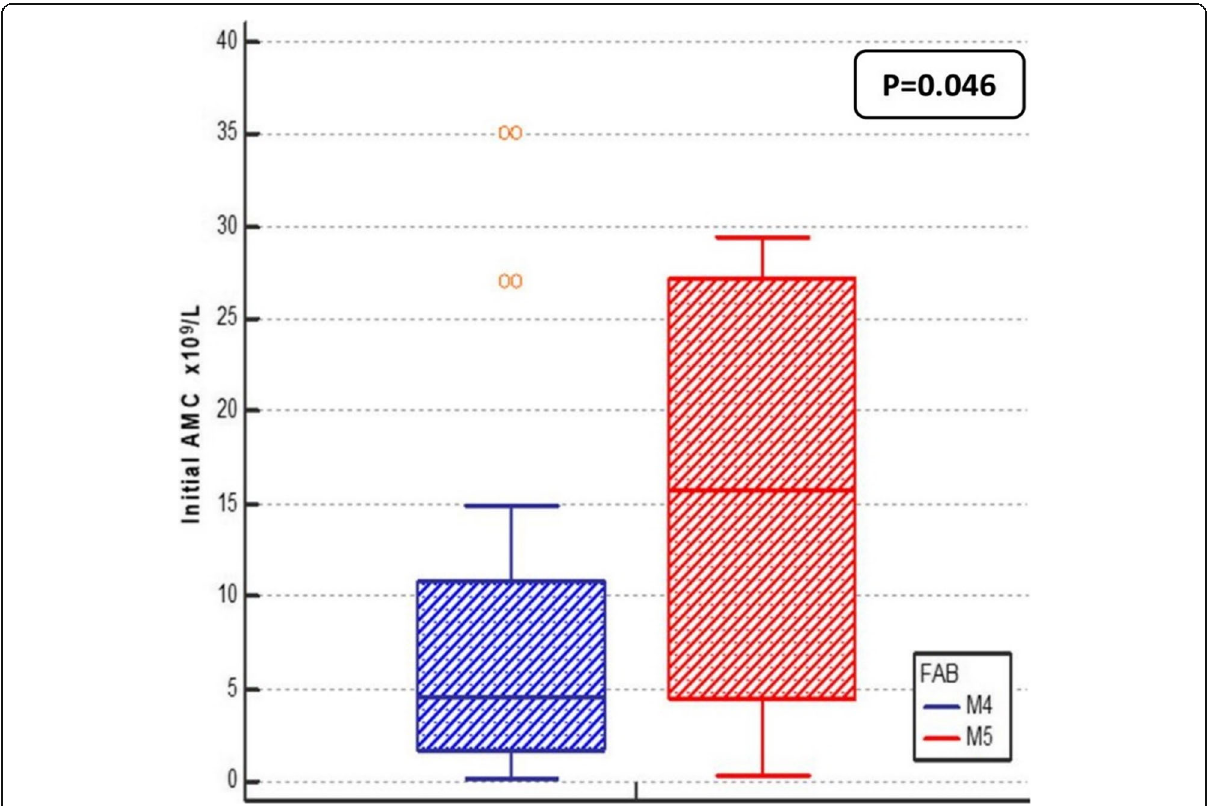
Fig. 2 Comparison between initial AMC level in AML-subgroups: Box-plot diagram represents the range of initial AMC (absolute monocyte count) level as regard FAB subtype, P = 0.046; the upper and lower line in each box represents the 75th and 25th percentile respectively while the line through each box indicates the median. Whiskers represent the range between the minimum and maximum values excluding outliers (rounded